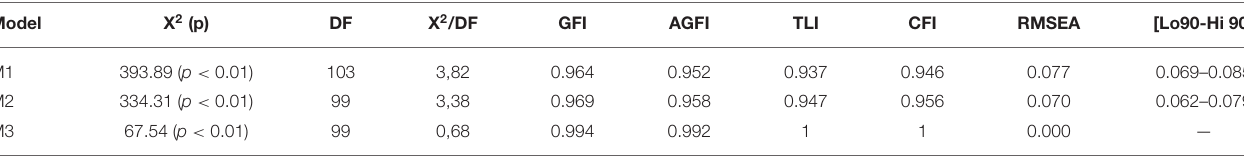
TABLE 4 | Fit indices of the three models of PE-Grit